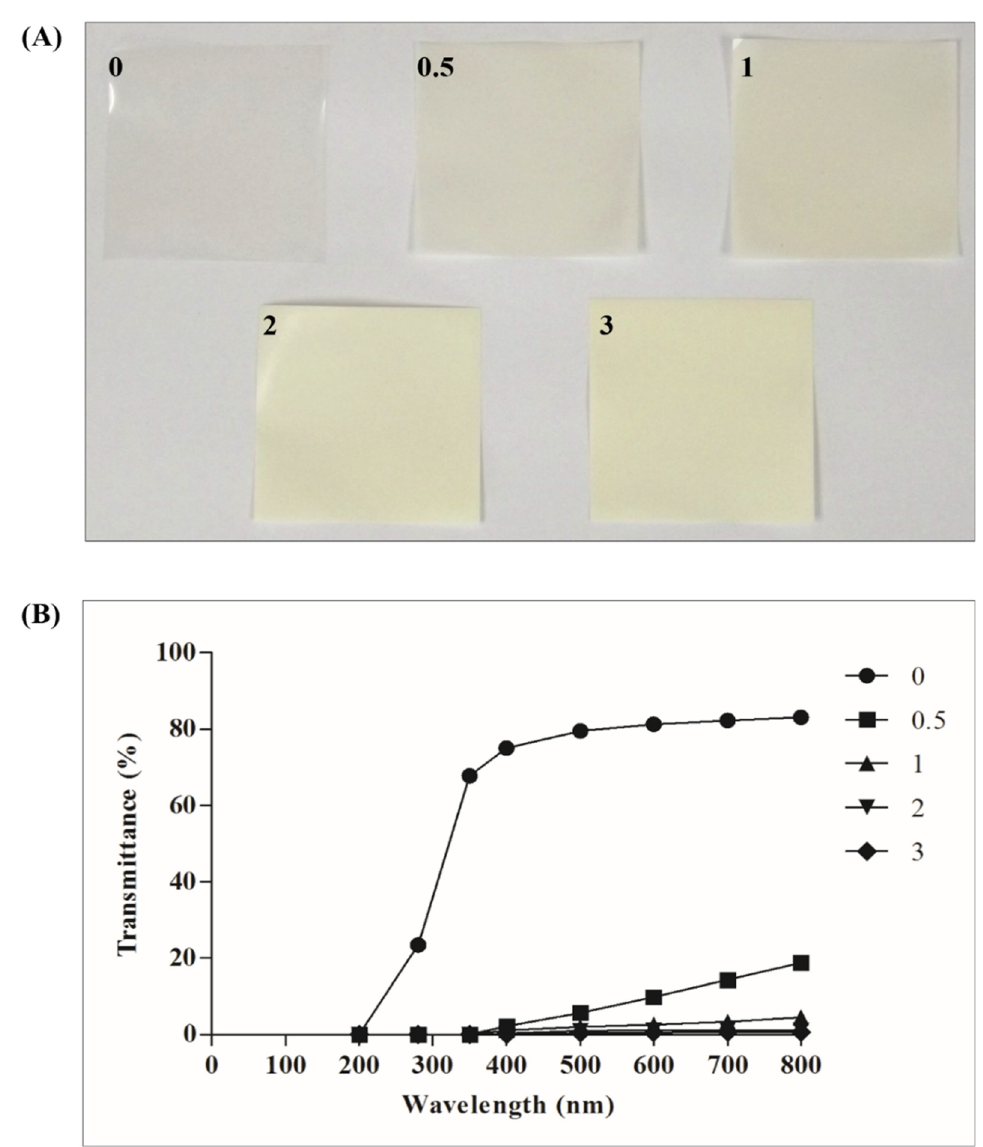
Figure 2 . Film appearance and color values ( A ) (0% ZnONPs, L* = 86.10 ± 0.10, a* = − 1.30 ± 0.06, b* = 2.48 ± 0.08, ∆ E* = 8.64 ± 0.08; 0.5% ZnONPs, L* = 86.56 ± 0.15, a* = − 2.68 ± 0.03, b* = 5.40 ± 0.39, ∆ E* = 9.53 ± 0.31; 1% ZnONPs, L* = 87.10 ± 0.07, a* = − 3.00 ± 0.13, b* = 7.14 ± 0.58, ∆ E* = 10.22 ± 0.44; 2% ZnONPs, L* = 88.04 ± 0.15, a* = − 1.62 ± 0.08, b* = 10.74 ± 0.27, ∆ E* = 12.25 ± 0.24; 3% ZnONPs, L* = 89.06 ± 0.17, a* = − 1.46 ± 0.03, b* = 12.16 ± 0.34, ∆ E* = 13.01 ± 0.36), and light transmittance ( B ) of RS–G films incorporated with different concentrations of ZnONPs. The numbers designate the ZnONPs concentrations (%, w / v ).